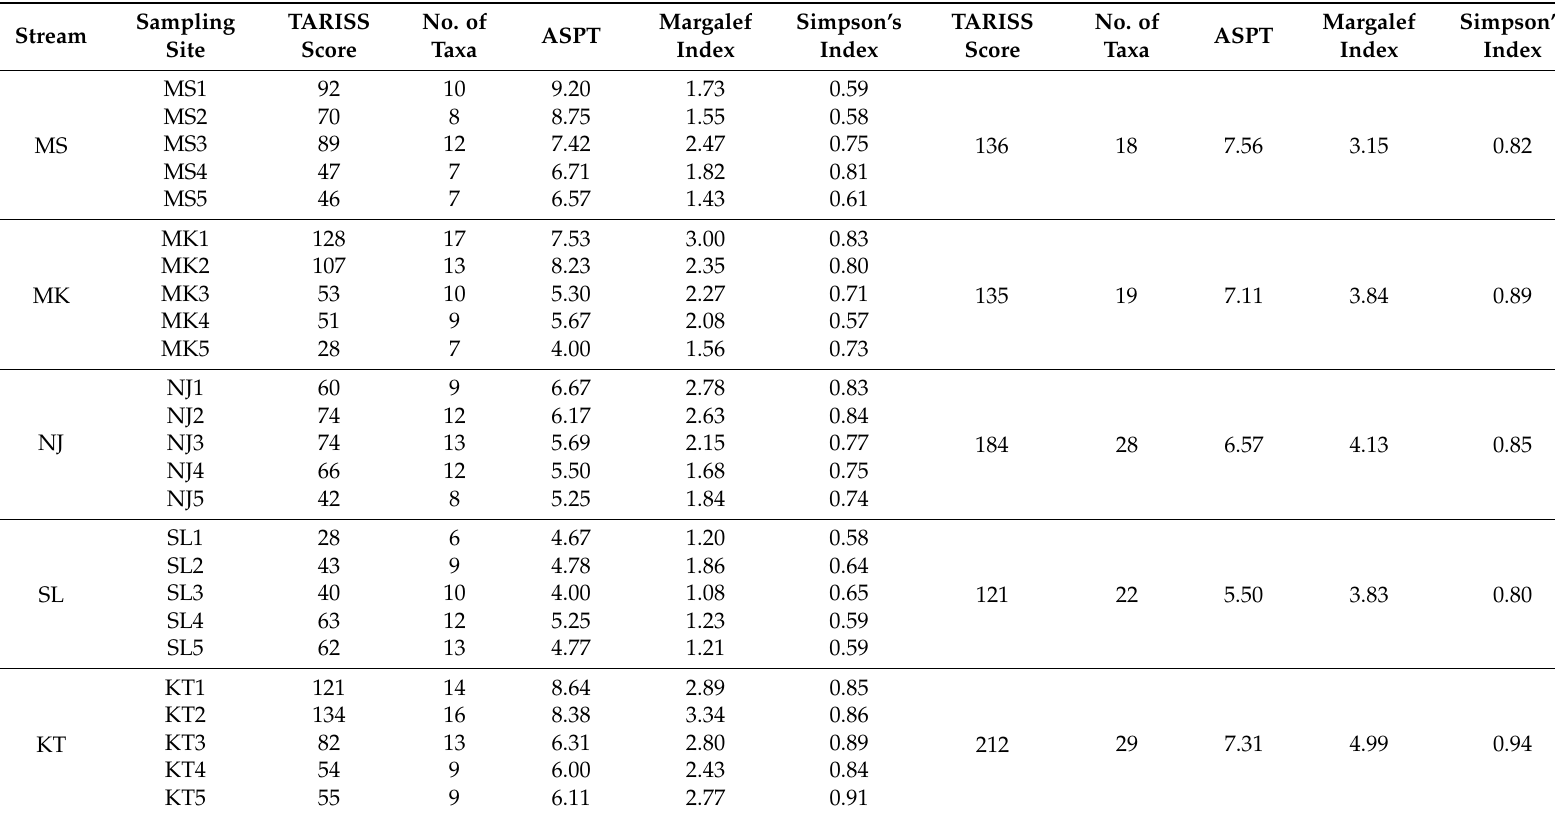
Table 1. Showing Tanzania River Scoring System (TARISS) score, number of taxa, average score per taxa (ASPT), Margalef richness index, Simpson’s diversity index